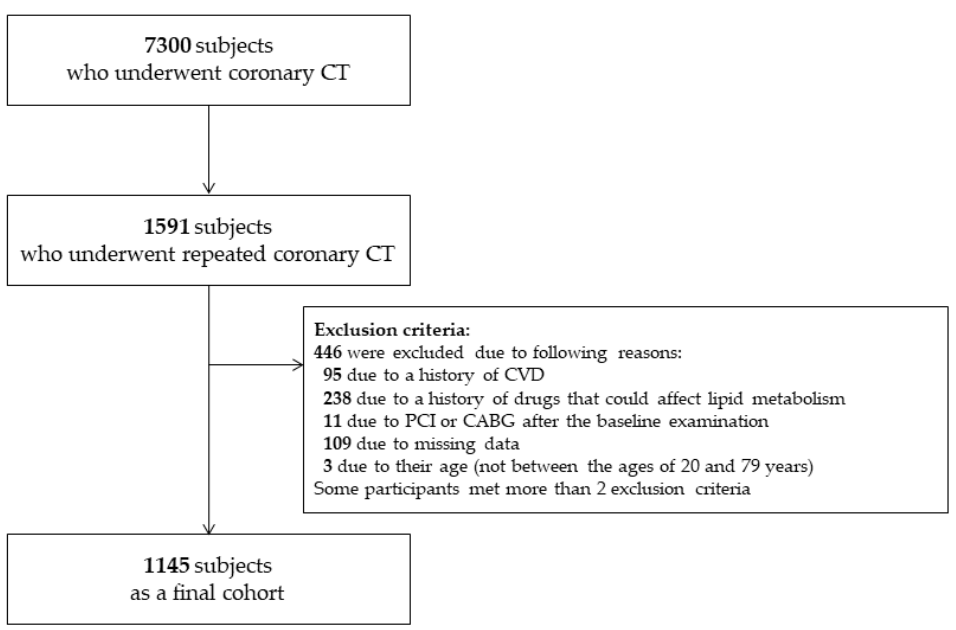
Figure 1. Study population. CABG, coronary artery bypass grafting, CVD, cardiovascular disease; PCI, percutaneous coronary intervention .